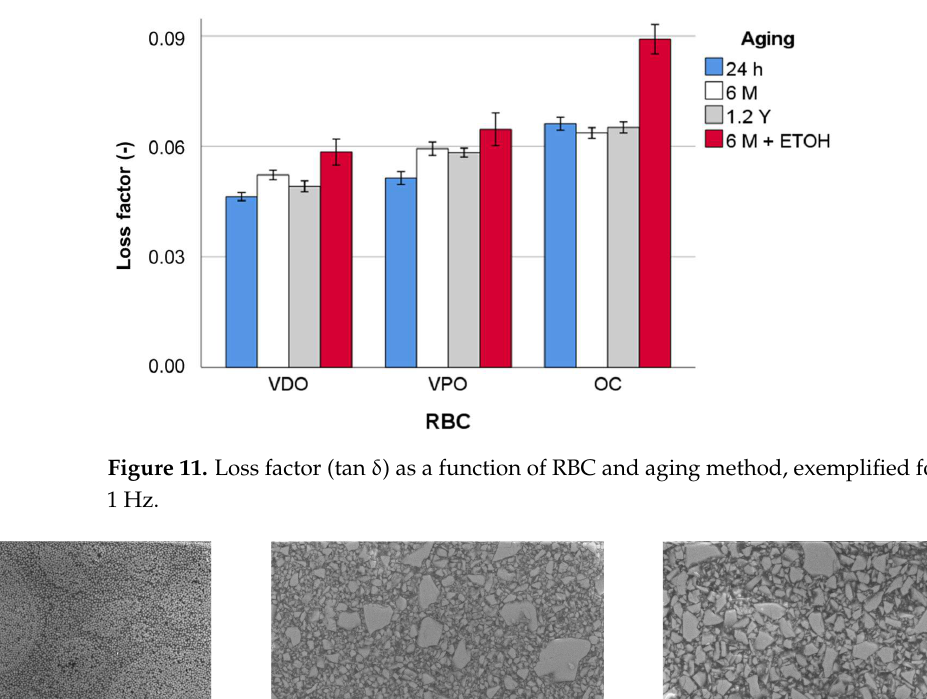
Figure 10. Storage modulus (E′) as a function of frequency and aging method, exemplified for the material OC.